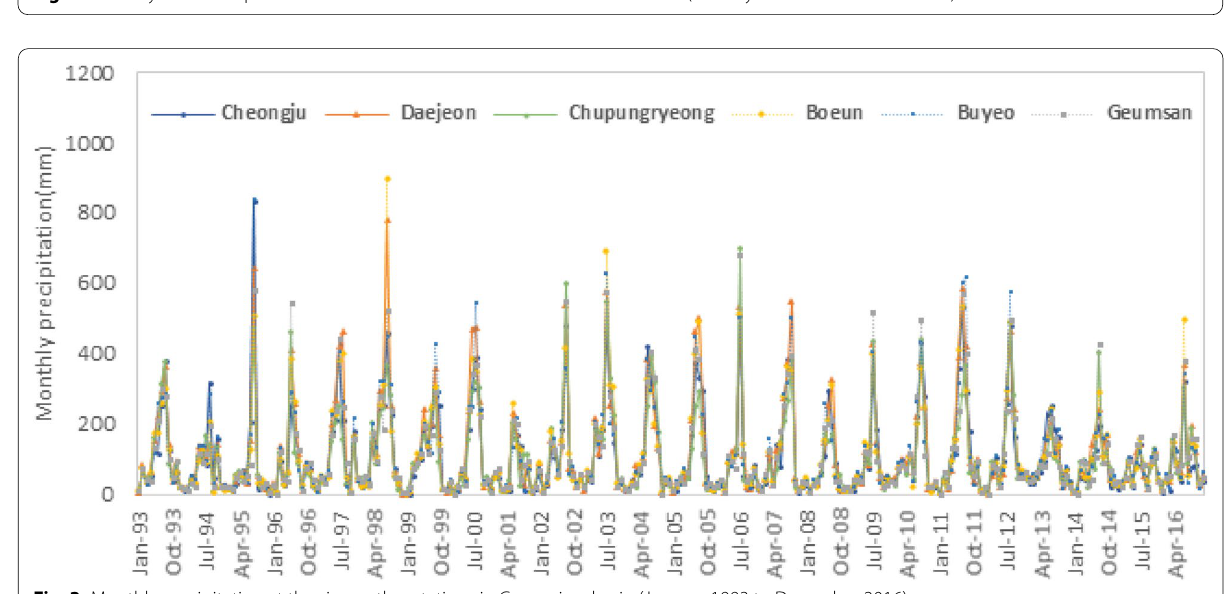
Seasonal prediction model for temperature and precipitation based on lagged teleconnection Global climate model (GCM) is known to reproduce atmospheric fluctuations more accurately on a global scale than a detailed climate distribution on a regional scale. Therefore, the indirect prediction of the long- term climate of a region based on identifying the fac- tors that directly or indirectly affect the regional climate using GCM is expected to have better performance. The method used to estimate the local climate using the cor- relation between the regional climate, and oceanic and